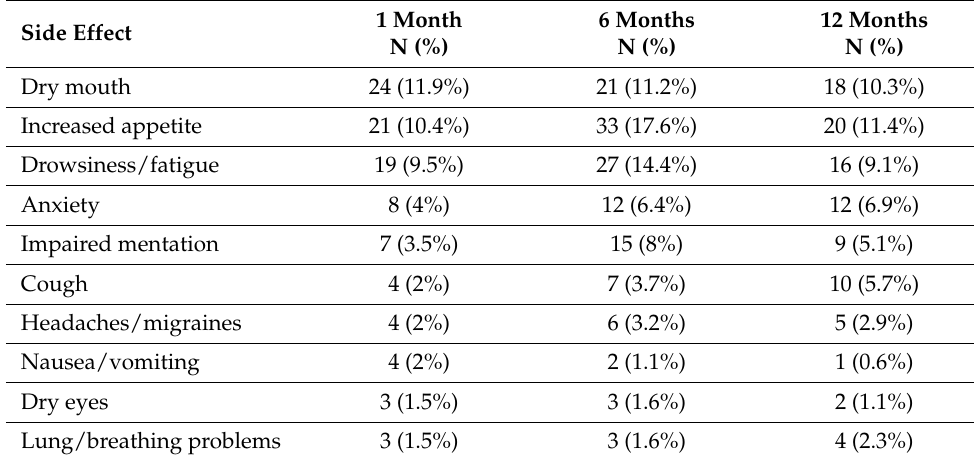
Table 5. Most Common Self-Reported Side Effects.